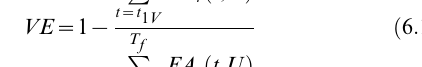
Figure S1 Frequency of resistant alleles after 10 years of chemotherapy. A) Reducing the frequency of treatment does not reduce the frequency of recessive alleles, unless the focus of resistance is highly isolated ( r =92%). B) Reducing the frequency of treatment always reduces the frequency of dominant alleles. The frequencies of (C) recessive and (D) dominant alleles increase with the relative susceptibility to drugs, defined as the ratio of the probabilities of being killed by drugs for susceptible and resistant worms. Baseline parameters are in Table 1 of the main paper. Figure S2 Frequency of recessive alleles within the